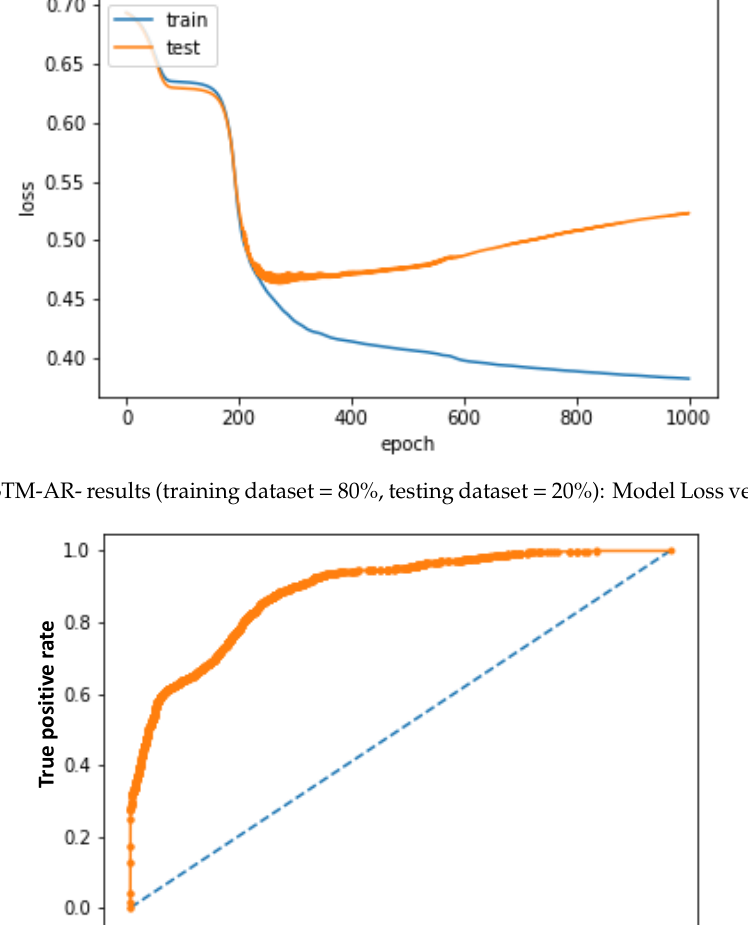
Figure 14. LSTM-AR- results (training dataset = 80%, testing dataset = 20%): ROC curve.